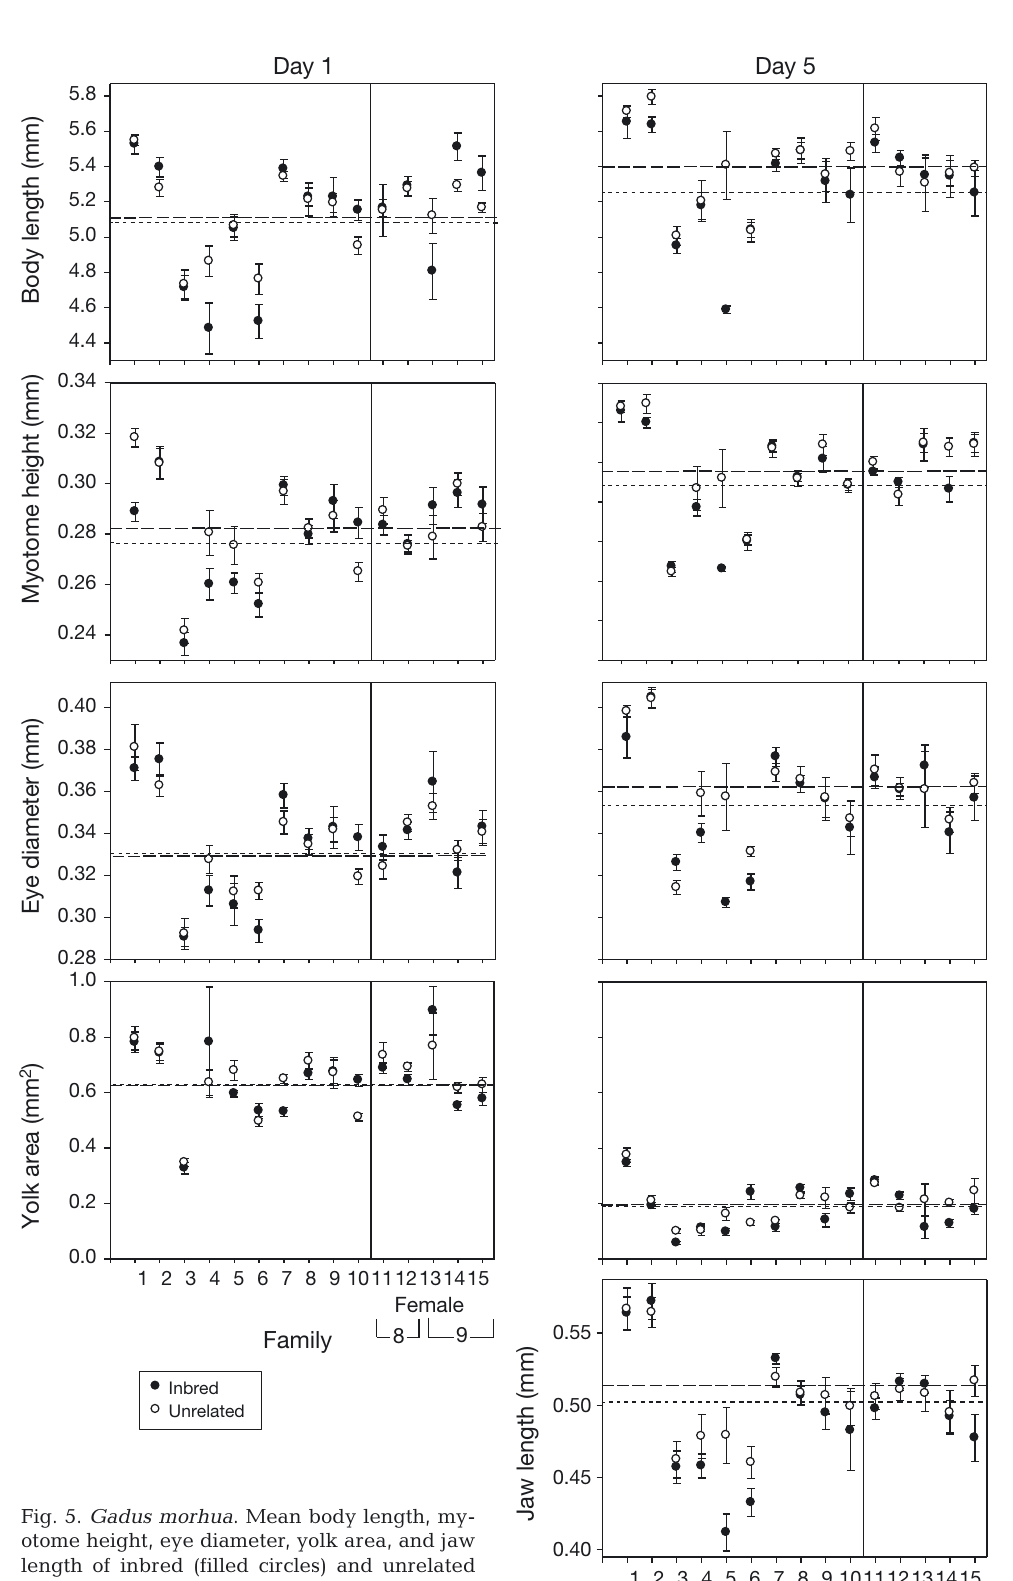
Fig. 5. Gadus morhua . Mean body length, my- otome height, eye diameter, yolk area, and jaw length of inbred (filled circles) and unrelated (open circles) Atlantic cod larvae on Days 1 and 5 (jaw length for Day 5 only). Further details as in Fig.